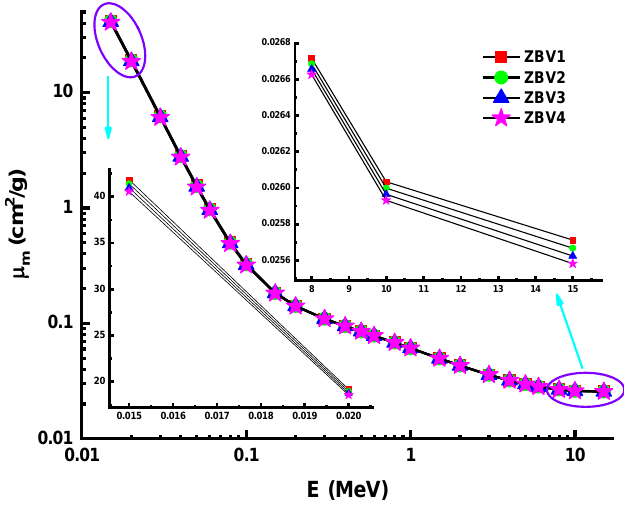
Figure 4. Variation of mass-attenuation coefficient ( µ m ) against photon energy for all glasses. HVL, which stands for “half-value layer” (T 1/2 ), is a valuable amount when measuring the thickness of a shielding material in order to minimize gamma rays. So, a smaller HVL may serve as a measure of a material’s capacity to shield incident gamma rays from a primary source. Using the calculated LAC values, the HVLs of the studied glasses were calculated. Figure 5 demonstrates the association between photon energy and T 1/2 for all glass samples. In the low-energy spectrum, calculations of HVL values were reported smaller. This is a predictable result for shielding in materials that low-intensity gamma rays cannot move through almost completely. To learn more about the efficiency of the studied materials as gamma-ray absorbers, we found it useful to compare them with some of the materials most commonly used as shields against gamma rays. The HVL value for the best glass sample (ZBV4 = 8.13915 cm) at 15 MeV was compared with other shielding materials (lead= 1.08069 cm, ordinary concrete = 13.89992 cm, HSC = 11.63975 cm, ILC = 9.40269 cm, IL = 7.81848 cm, G1 = 15.25284 cm, and G2 = 10.53327 cm) glasses [54,55]. The comparison shows that the ZBV4 glass came third after lead, and with IL outperforming the other shield types. Considering its other distinguishing features, such as lack of toxicity risk and lower weight, this glass is recommended as the ideal choice in many applications that require gamma-ray shields with specific properties.